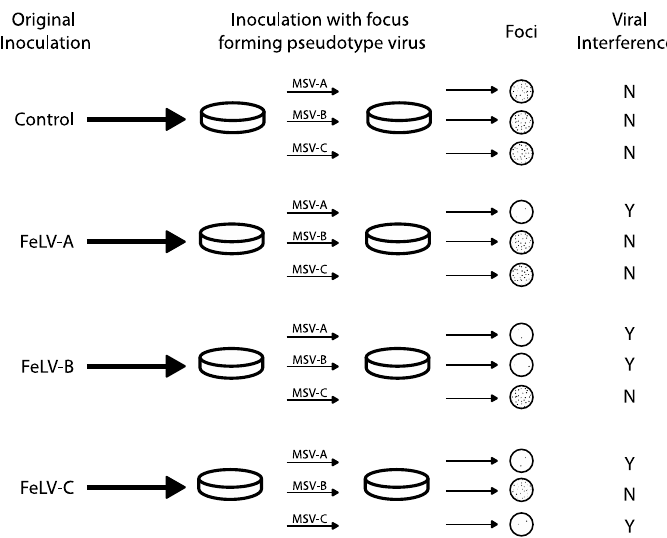
Figure 2. Predicted outcomes of FeLV viral interference as defined by Sarma and Log, 1971 [19]. FeLV subgroups were first identified by ability or inability of virus types to infect Murine sarcoma virus (MSV)-infected hamster cells (Sarma and Log, 1971 [19]). Focus-forming pseudotypes (chimeras with the ability to form plaques) were plated on previously infected cell cultures. Cultures with a 2-log reduction in focus-forming units were considered to demonstrate viral interference.